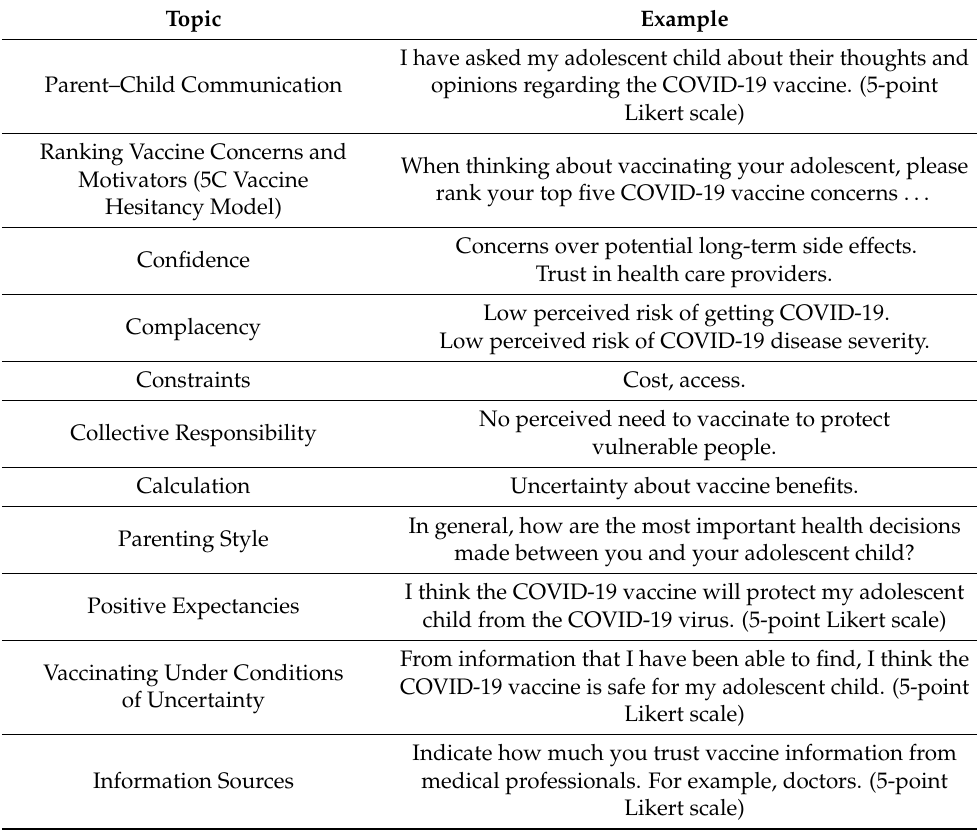
Table 1. Overview of Survey Question Domains for